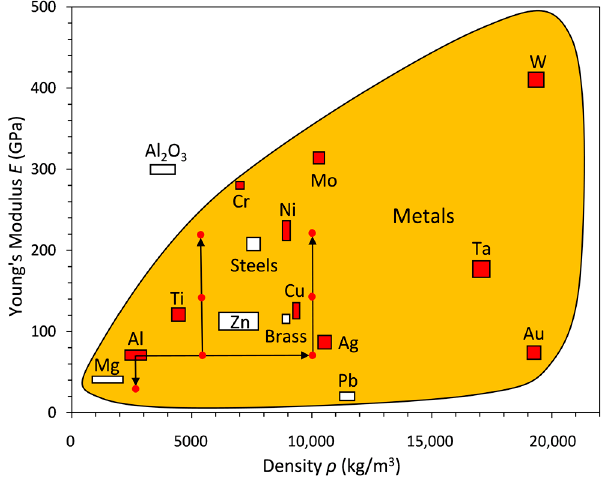
Figure 6. Young’s modulus density chart for different metals (completely redrawn using ideas of Reference A [ 42] ).